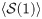
Symmetry of the traded volume v semester s.The black dots—with the black line as a guide to the eye—represent the values of the mean symmetry normalised by the value of 〈S(1)〉; the horizontal lines signal the average value (computed over all companies and semesters) and the upper and lower error limits.